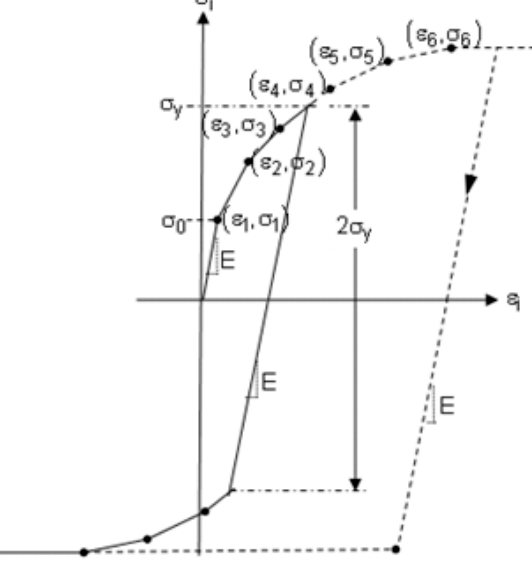
Figure 7. Multilinear isotropic hardening behavior.